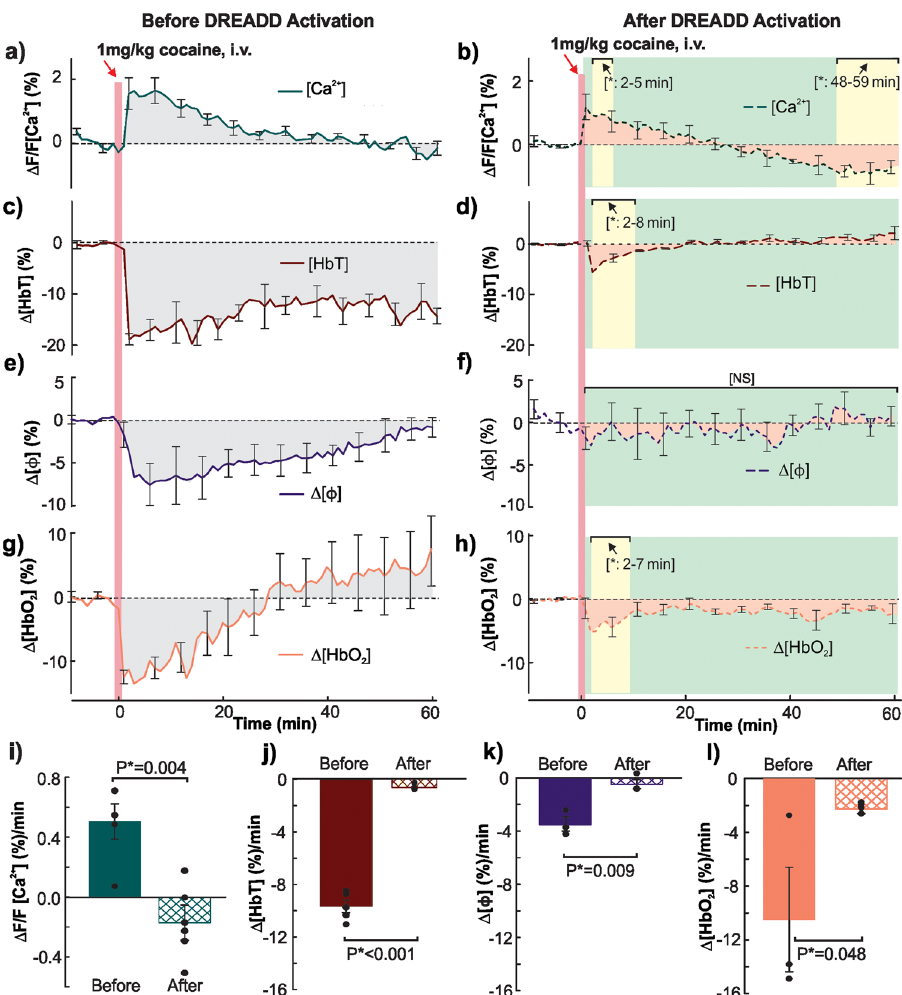
Fig. 7 Inhibiting astrocytic activity with clozapine in GFAP-DREADD (Gi) expressing mice blocked cocaine-induced vasoconstriction. Cocaine induced Δ F = F ( a , b ), HbT ( c , d ), vessel diameter size ( e , f ), and HbO 2 ( g , h ) changes as function of time before and after astrocytic Δ Ca 2 + inhibition by Ca 2 þ - G ð D Þ clozapine. i – l Quanti fi cation analysis of average ef fi ciency in Δ F = F , vessels size, hemodynamic response respectively before DREADD(Gi) Ca 2 þ - G ð D Þ activation (Gray shadow in a , c , e , g ) and after DREADD(Gi) activation by clozapine (Pink shadow in b , d , f , h ). Meanwhile, yellow shadow indicates time periods with signi fi cant differences compared to baseline ( p < 0.05), and green shadow indicate no-signi fi cant differences ( p > 0.05). All error bars are presented as means ±